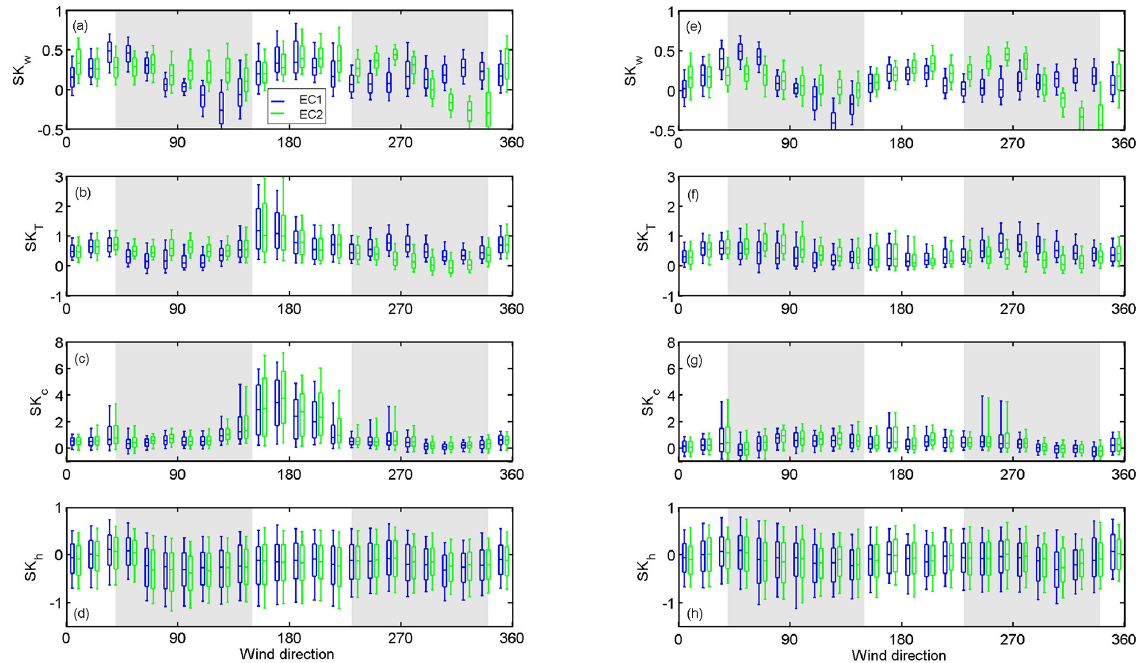
Figure 7. Skewness (SK) of (a, e) vertical wind speed ( w ), (b, f) air temperature ( T ), (c, g) CO 2 ( c ) and (d, h) water vapour ( h ) as a function of wind direction for hours 06:00–21:00 (a) – (d) and 21:00–06:00 (e) – (h) for EC1 (blue) and EC2 (green) during July 2013 until September 2015. Whiskers and boxes represent the 10th, 25th, 50th, 75th and 90th percentiles.